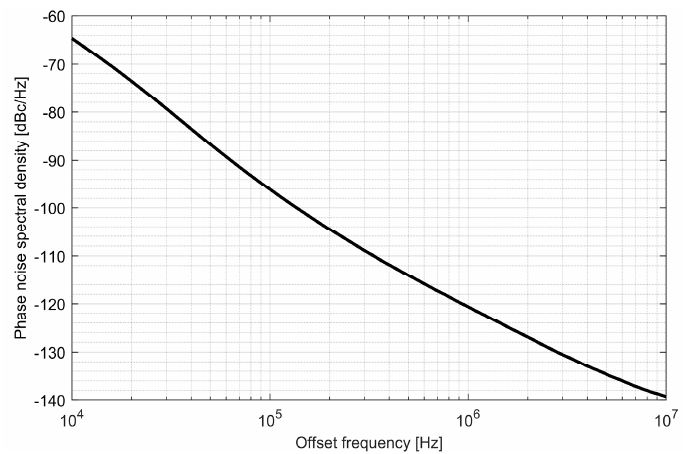
Figure 21. Phase noise of the L1/E1 digitally controlled oscillator.